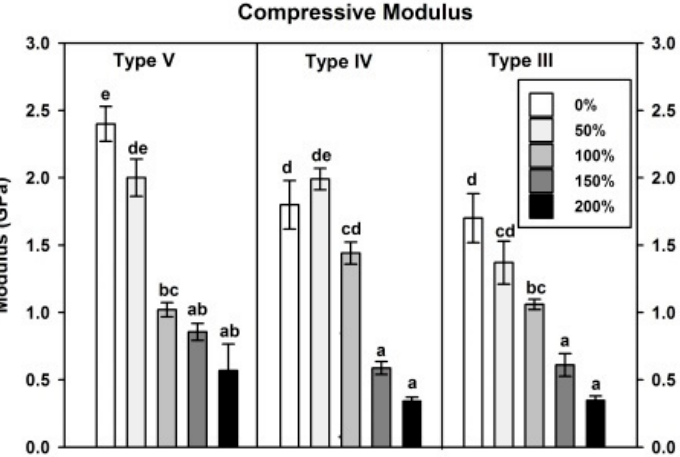
Figure 3. Bar chart of one-hour compressive modulus for three gypsum types and five water dilutions. Error bars represent standard errors of means; groups with different letters are significantly different at α = 0.05 confidence level. Comparisons are both within and across gypsum types.